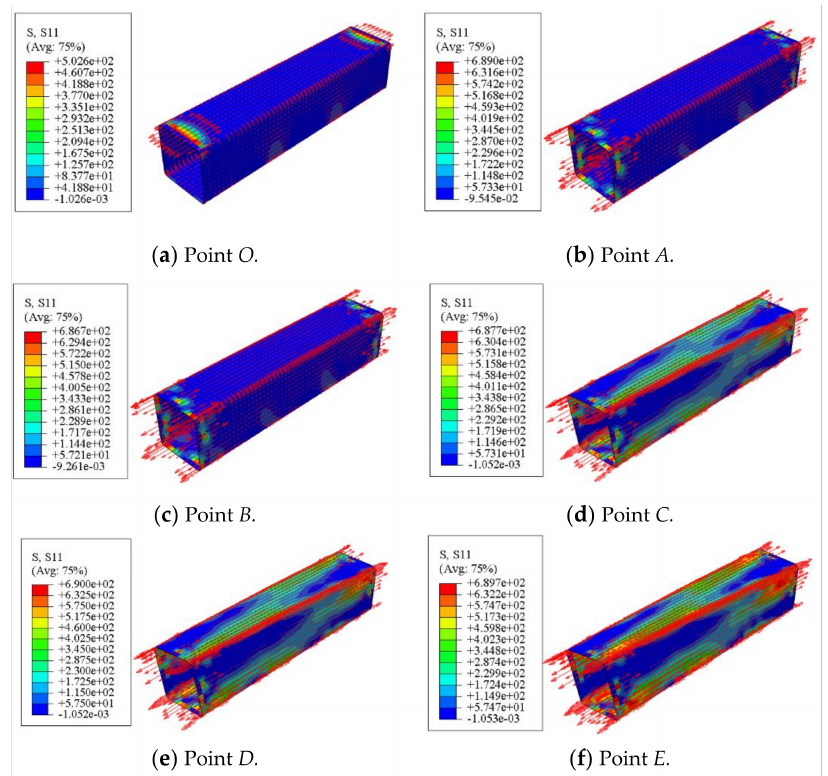
Figure 19. Stress distribution of longitudinal